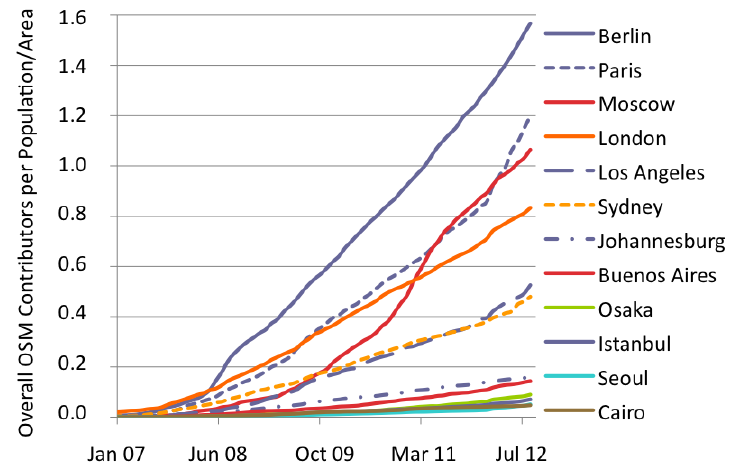
Figure 2. Number of OpenStreetMap (OSM) Contributors per Population/Area-ratio (Jan. 2007–Sept.